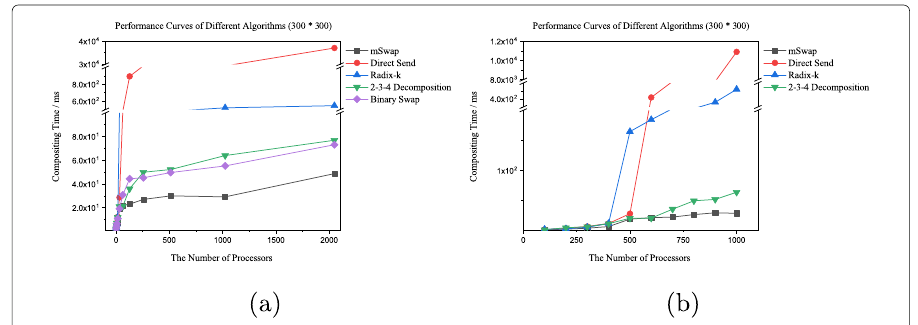
Fig. 7 Performance curves of different algorithms with a resolution of 300 ∗ 300. a is the compositing time when the number of processors is power-of-two. b is the compositing time when the number of processors is non power-of-two without Binary Swap